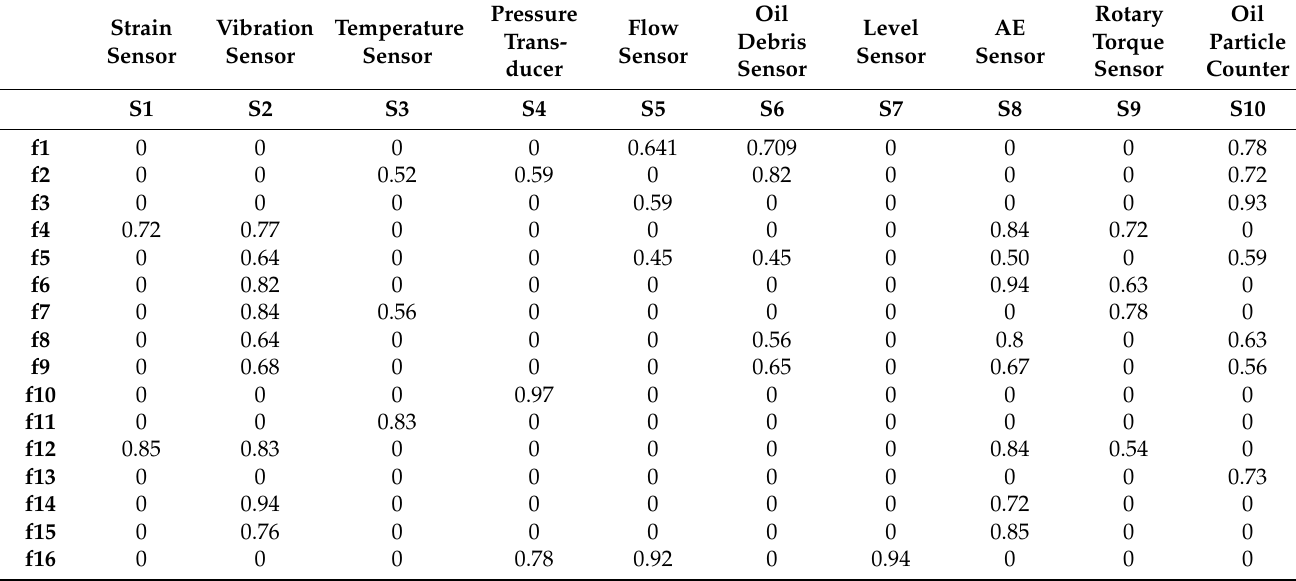
Table A1. Sensor and fault mapping with their probability of